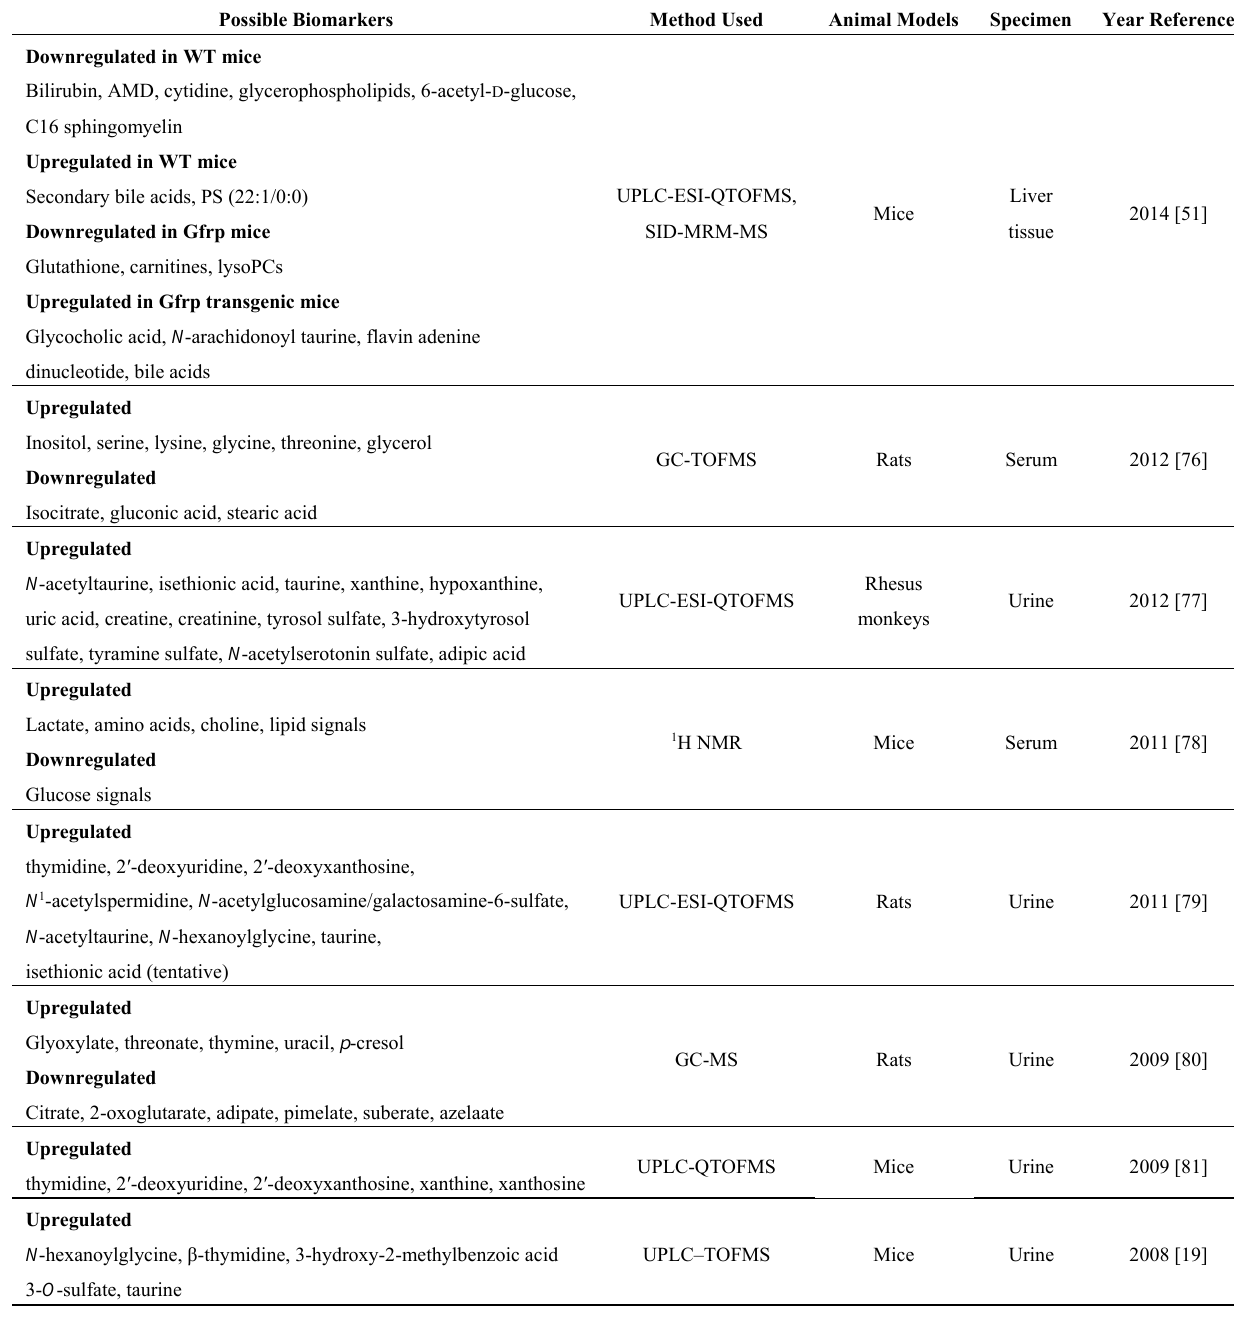
Table 1. Possible biomarkers reported in selected recent metabolomics studies were either downregulated or upregulated in irradiated